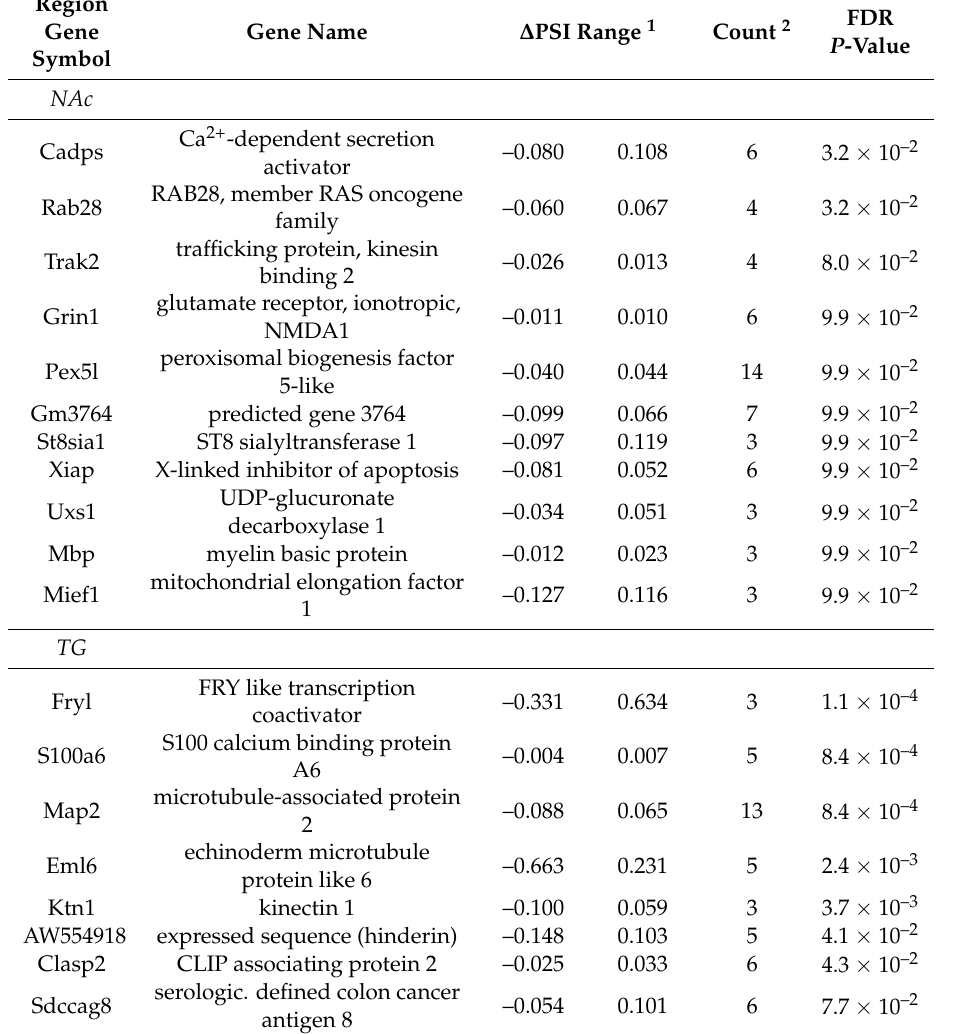
Table 3. Relative differential expression of transcript isoform clusters (FDR-adjusted P -value < 0.1) between opioid-induced hyperalgesia and control mice in the nucleus accumbens (NAc) and trigeminal ganglia